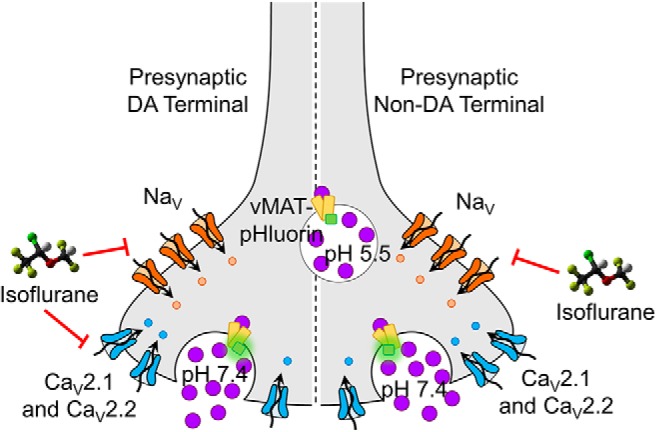
Presynaptic mechanisms of isoflurane. In non-dopaminergic (non-DA) neurons, isoflurane inhibits SV exocytosis by inhibiting Na+ channels to reduce nerve terminal excitability. In dopaminergic (DA) neurons, isoflurane can also reduce SV exocytosis by a Na+ channel-independent mechanism mediated by inhibition of CaV2.1 and CaV2.2. The fluorescence of vMAT2-pHluorin is quenched by the acidic (∼pH 5.5) SV interior. On exocytosis and fusion with the plasma membrane, vMAT2-pHluorin fluoresces on exposure to the pH neutral (∼pH 7.4) synaptic cleft.